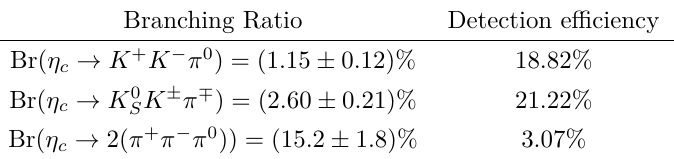
= ε = 3 . 7 × 10 − 3 , ε c u